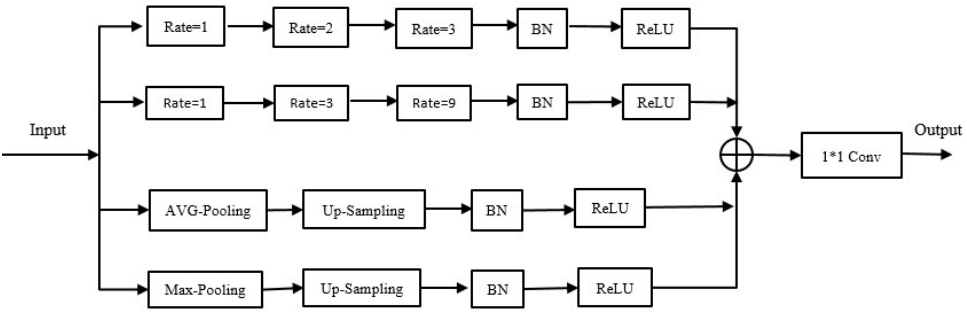
Figure 2. Structure of the MSFF module.